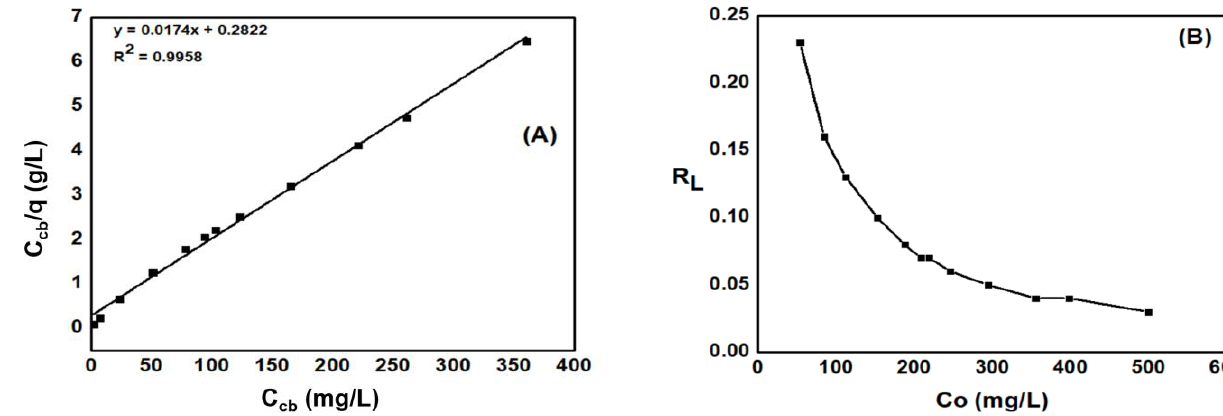
Figure 9. ( A ) The effect of C cb on C cb /q for MB adsorption and ( B ) correlation of R f and C 0 .